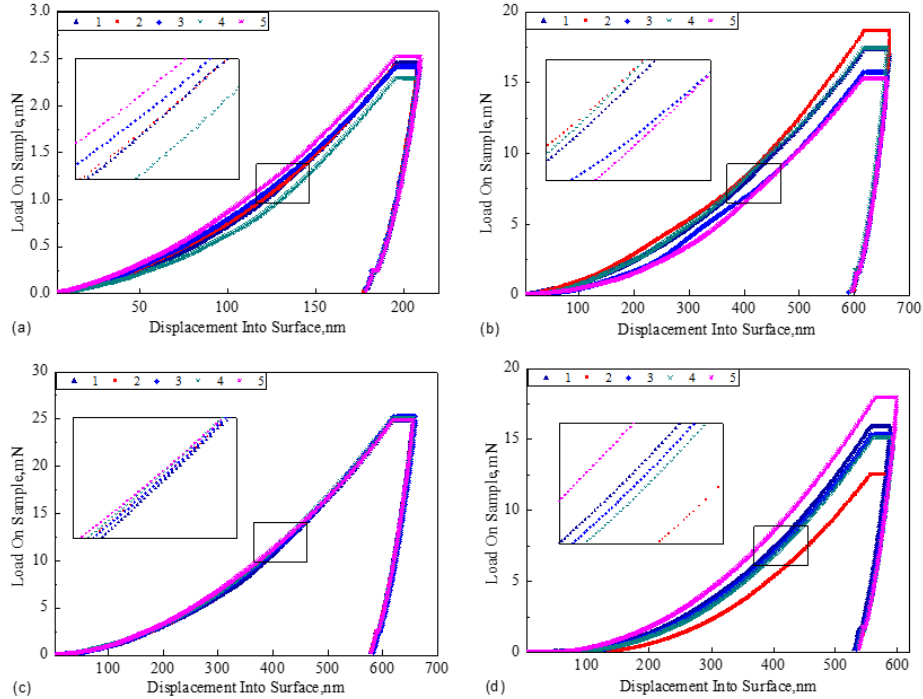
Figure 8. Load–displacement curve of Cu film under different peak currents: ( a ) 2 A, ( b ) 8 A, ( c ) 13 A, and ( d ) 18 A.